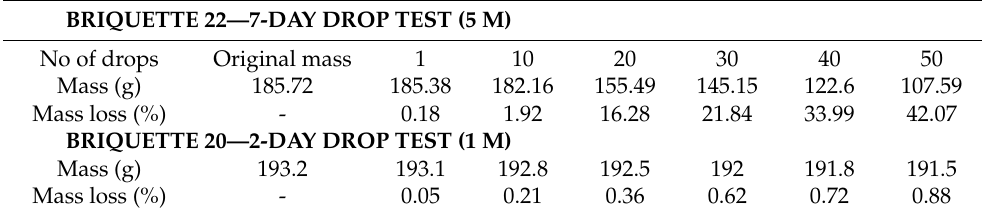
Figure 19. Mass loss in drop tests conducted after 2 and 7 days of curing in ambient air. Table 15. Two-day drop test (from 1 m height) and 7-day drop test (from 5 m height).